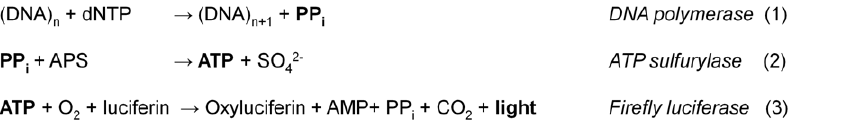
Figure 1. Biochemistry of ELIDA and BART. Schematic biochemical reactions describing nucleic acid amplification (1) coupled with bioluminescent detection of inorganic pyrophosphate using ELIDA (2) and (3).